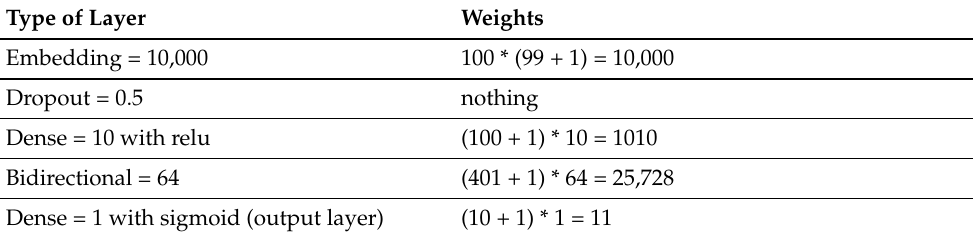
Table 7. Layered-wise details for